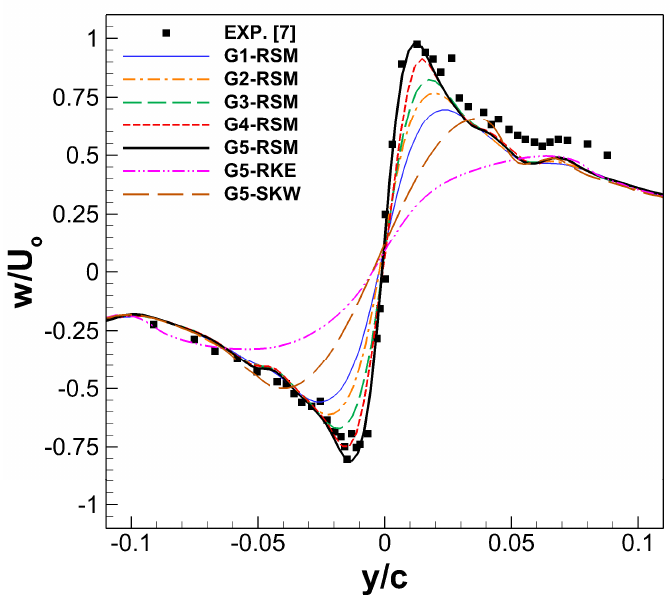
Figure 4. Vertical velocity profiles at the section of x/c = 1.0.